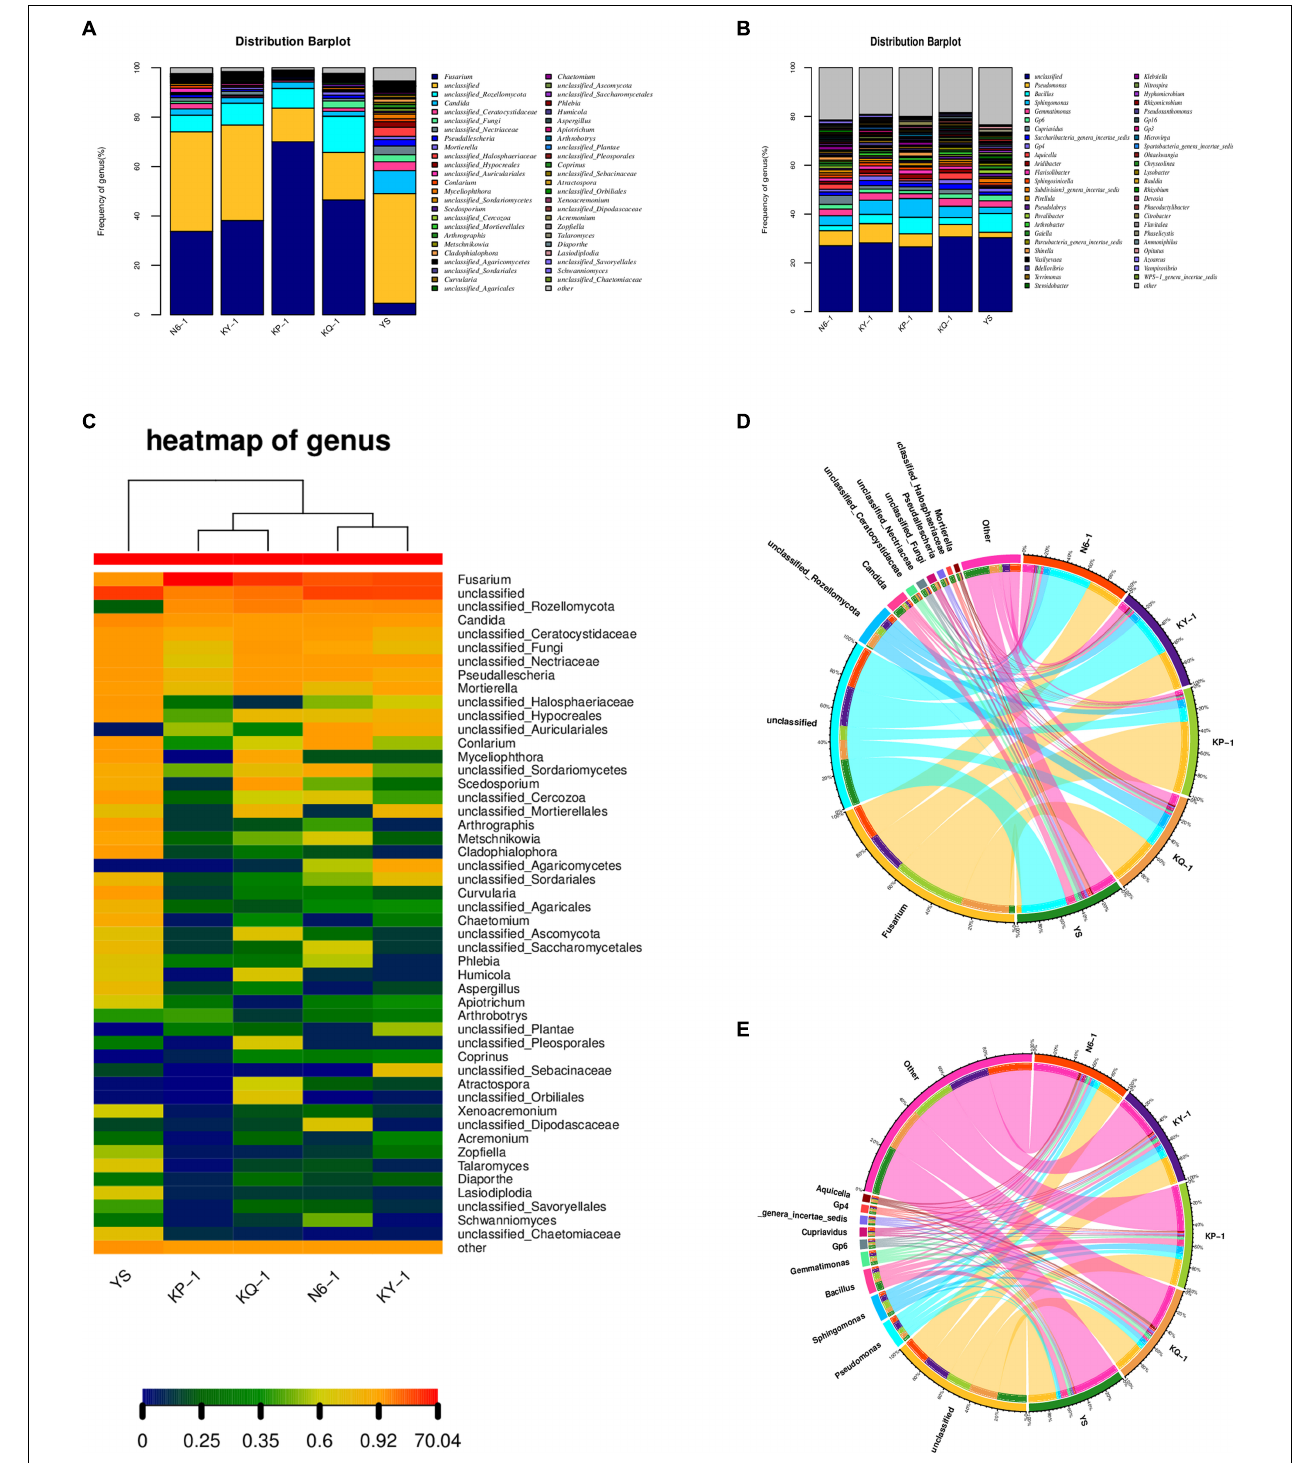
FIGURE 5 | Effect of strain HN6 on the composition of rhizosphere soil microbial community. N6 ( Foc · TR4-GFP + HN6, 1.0 × 10 7 cfu g − 1 soil), KY ( Foc · TR4-GFP + 0.1% carbendazim), KP ( Foc · TR4-GFP + Gause No. 1 liquid medium), and KQ ( Foc TR4-GFP + sterile water). YS referred to rhizosphere soil of uninoculated plants. (A) Fungi community structure. (B) Bacterial community structure. (C) Heatmap of fungal genera. (D) Sample–species relationship diagram of fungi at genus level. (E) Sample–species relationship diagram of bacteria at genus level.